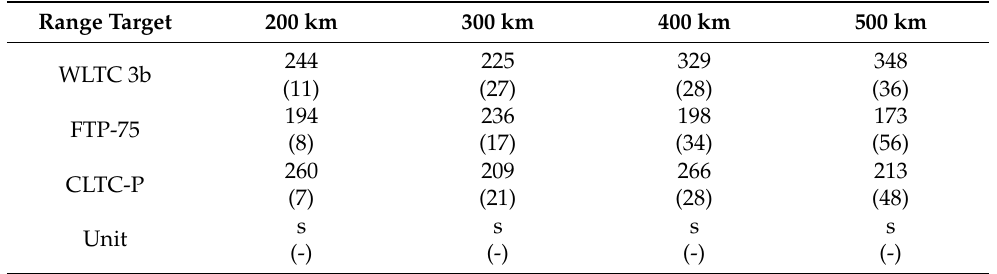
Table 14. Average REX single instance running time and the total number of engagements (in parentheses) for four range targets in WLTC 3b, FTP-75, and CLTC-P drive cycles. Vehicle mass is 1500